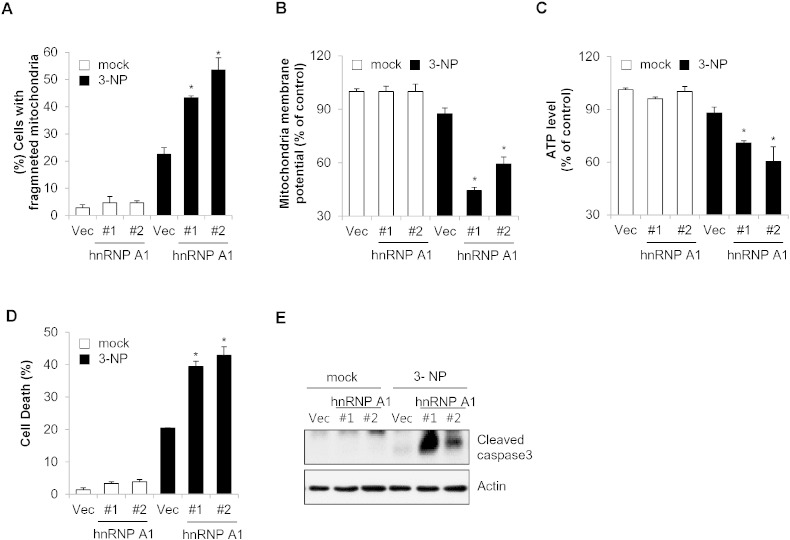
Over-expression of hnRNP A1 potentiates 3-NP-mediated mitochondrial dysfunction and cell death.SK-N-MC/GFP and SK-N-MC/GFP-hnRNP A1 cells were treated with 3-NP (10 mM) or not for 8 h. (A) Mitochondrial fragmentation was observed under a fluorescence microscope. (B and C) The mitochondrial membrane potential (B) and intracellular ATP level (C) were addressed using assay systems as described in the Materials and methods section. (D and E), SK-N-MC/GFP cells (Vec) and SK-N-MC/GFP-hnRNP A1 cells (hnRNP A1#1, and #2) were treated with 3-NP (10 mM) for 24 h. And cytotoxicity and caspase activation were analyzed by LDH activity assay kit (D) and cleaved caspase-3 antibody (E). Data are represented as the mean ± SEM (n > 3, and *p < 0.05 value).